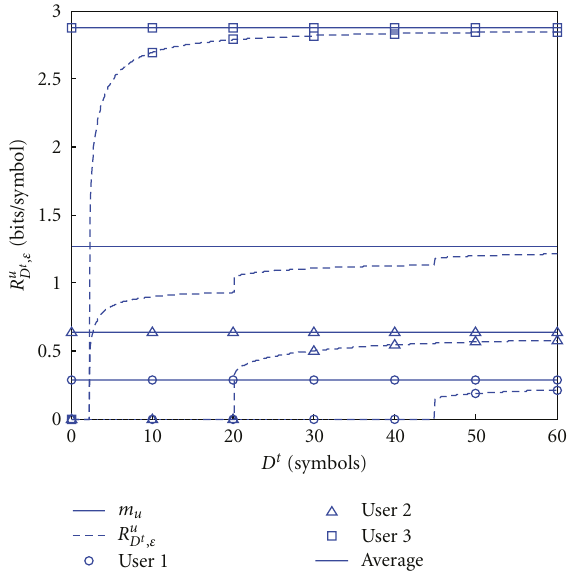
Figure 3: Achievable users’ rates with Best Channel scheduling in an uncorrelated channel. Three users with γ respectively. ε = 0 . 1. β u =